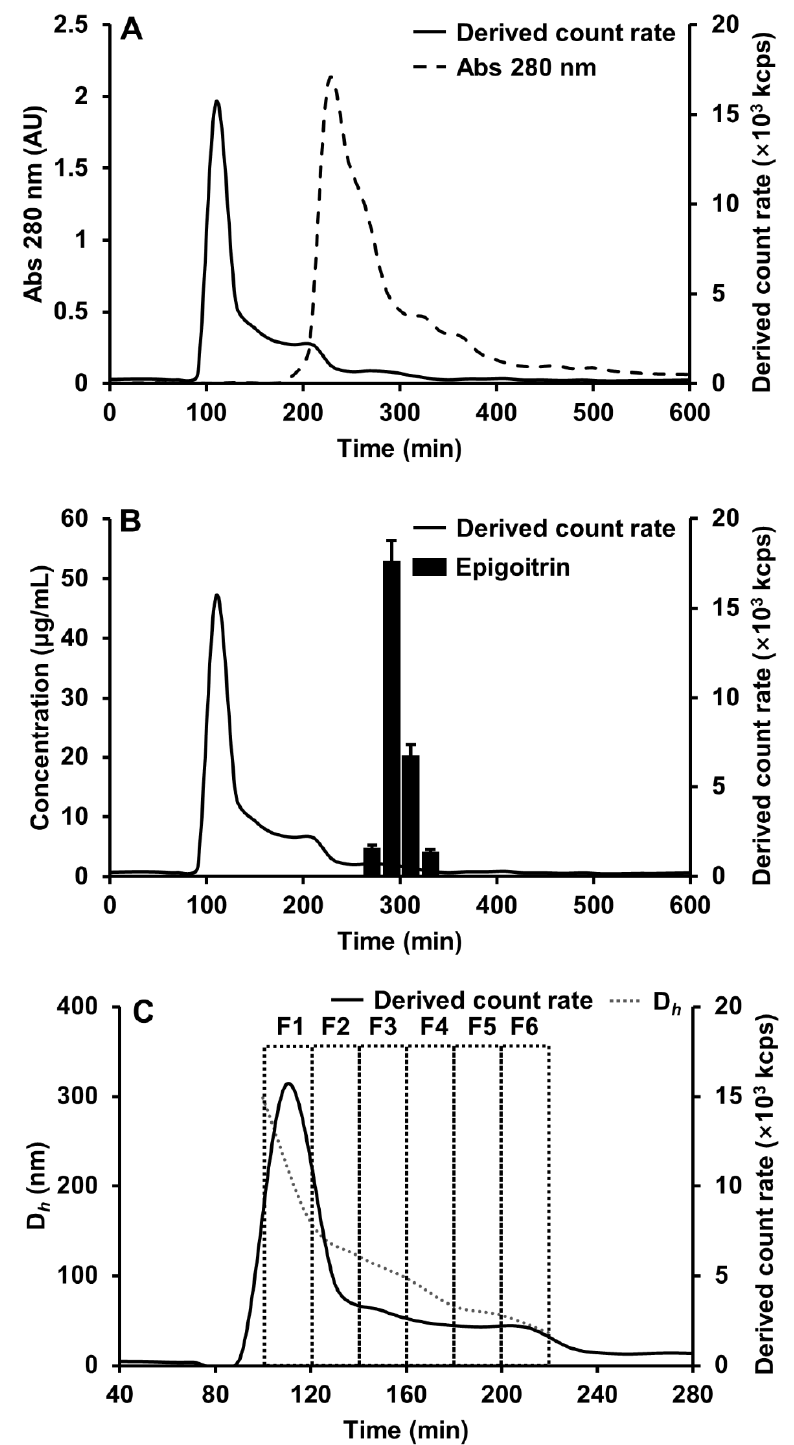
Figure 1. Isolation of BLG nanoparticles fractions derived from the BLG decoction using SEC-DLS. The Sephacryl S-1000 column (1.0 cm × 100 cm) was equilibrated and eluted with 0.02 M Phosphate buffer (pH 5.0) at a flow rate of 0.35 mL/min. ( A ) SEC-DLS isolation of the BLG nanoparticles fractions. ( B ) The content of epigoitrin in the fractions isolated from the BLG decoction. ( C ) The average hydrodynamic diameter radius distributions (dash line) of BLG nanoparticles fractions. Solid line: derived count rate which is light scattering intensity; dashed line: UV absorption at 280 nm; black column: the content of epigoitrin; gray dot line: the average hydrodynamic diameter